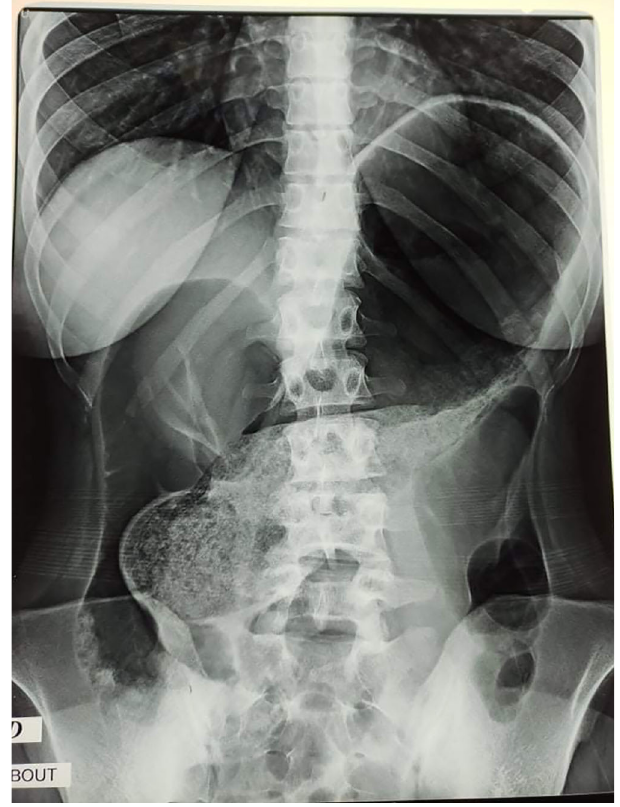
Figure 1. Abdominal X-ray showing the Significant distension of the colon reaching the epigastrium and the left